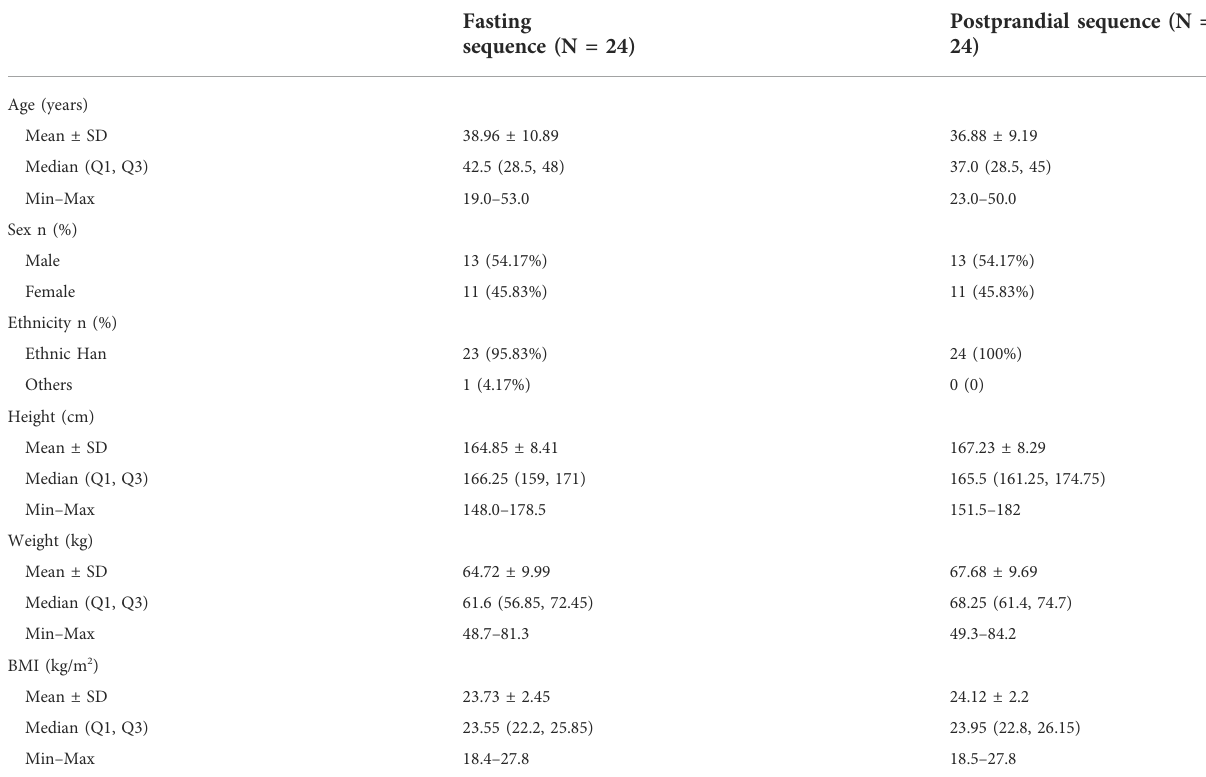
TABLE 1 Demographic and baseline characteristics of the study